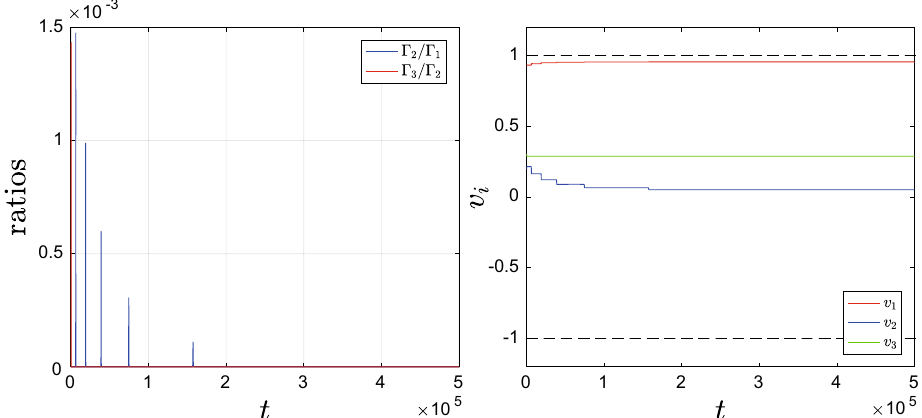
Fig. 3 Plots of the ratios (cid:12) 2 /(cid:12) 1 , (cid:12) 3 /(cid:12) 2 and the velocity (cid:11) v . The plots correspond to the numerical solution presented in Fig. 2. The peaks in the ratios appear during bounces of the universe point with the centrifugal walls. As we can see, the height of these peaks decreases in the evolution towards the